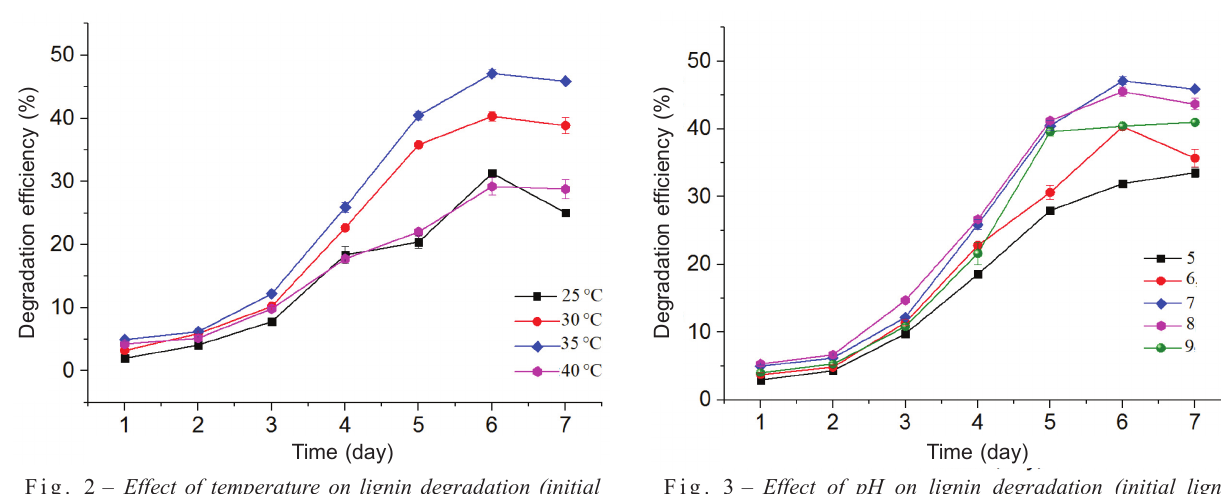
Fig. 2 – Effect of temperature on lignin degradation (initial lignin concentration = 1 g L –1 , shaking speed = 120 rpm, pH = 7, inoculation amount = 5 %)